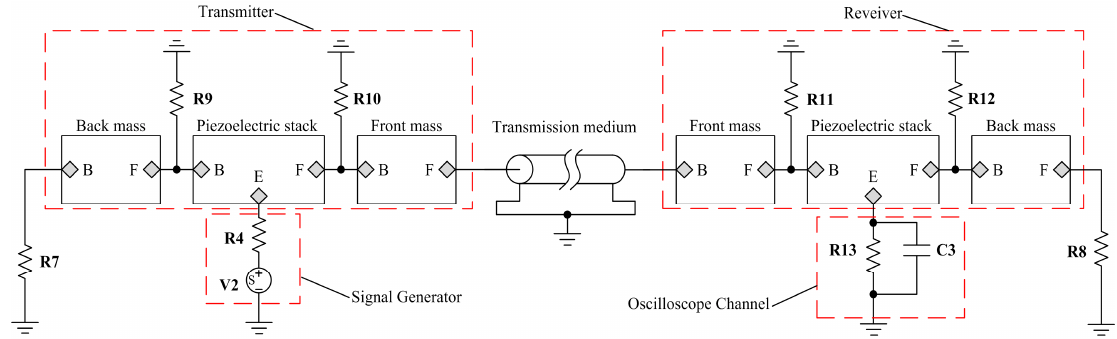
Figure 14. The simulation circuit of the pitch-catch setup.